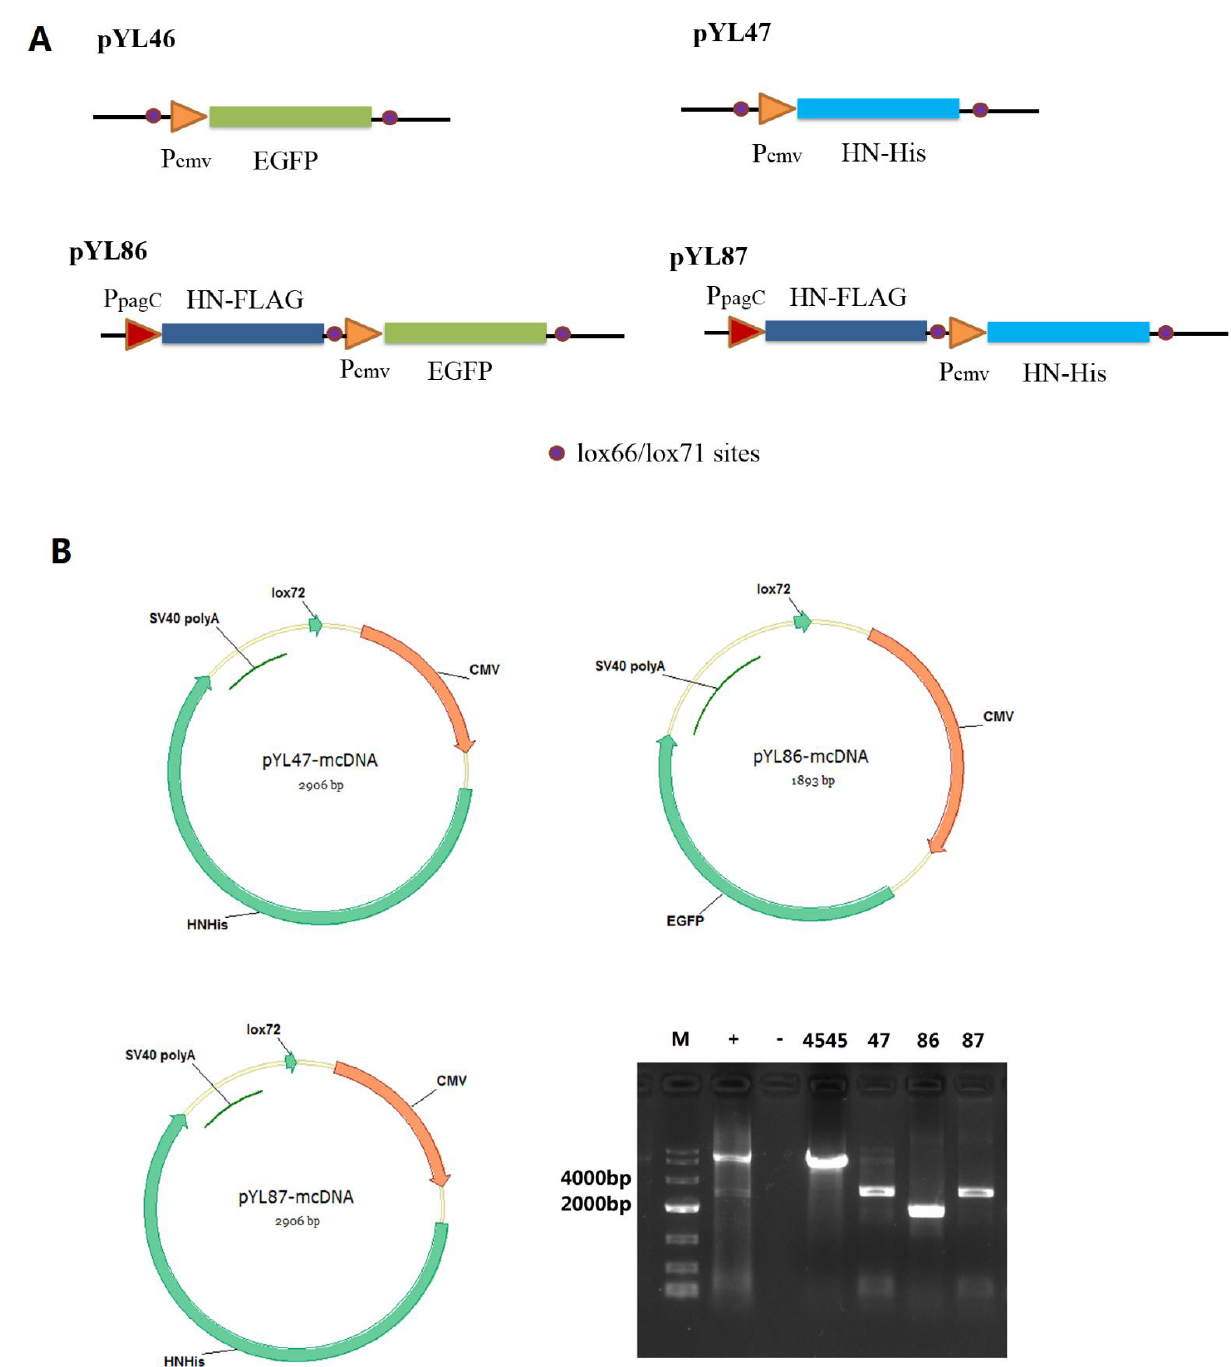
Figure 1. Construction of designed plasmids. pYL46 and pYL47 were used as original templates by inserting P pagC -HN-TT cassette, yielding pYL86 and pYL87, respectively ( A ). The minicircle DNA derived from pYL47, pYL86, and pYL87 was confirmed by DNA extraction from cells transfected with individual plasmids, followed by PCR amplification ( B ). M: DNA marker DL10000 (Takara); +: PCR amplification using parental pYL47 plasmid as positive control; -: PCR amplification without template as negative control; 4545: PCR amplification using the extracted DNA from pYA4545 transfected cells as template; 47,86,87: PCR amplification using the extracted nuclear DNA from individual plasmid transfected cells as